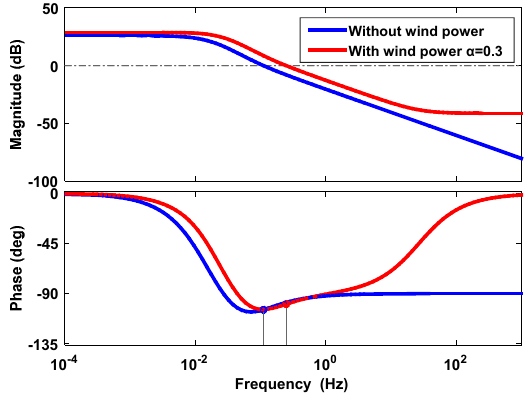
Figure 6. Bode plots of the closed-loop system for stability analysis.